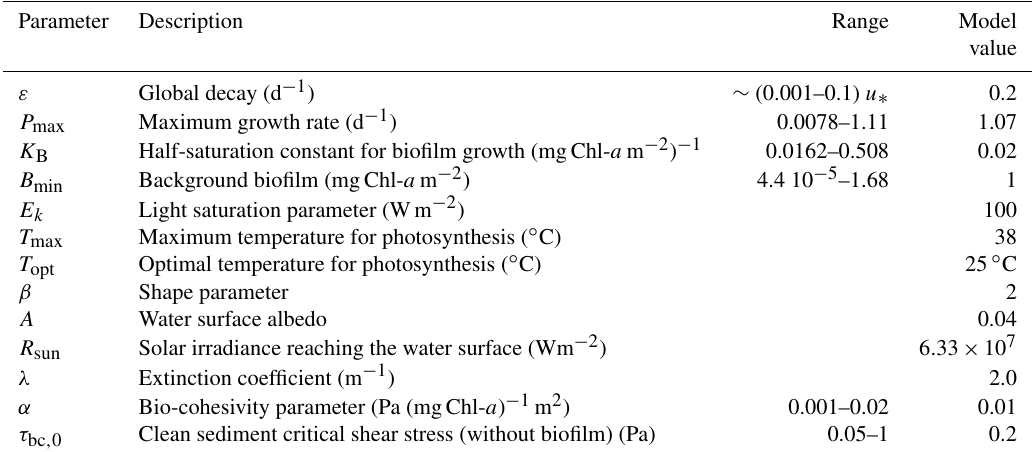
Table 2. Parameter ranges found in the literature (Mariotti and Fagherazzi, 2012; Pivato et al., 2019) and parameter values used as a reference in the model.